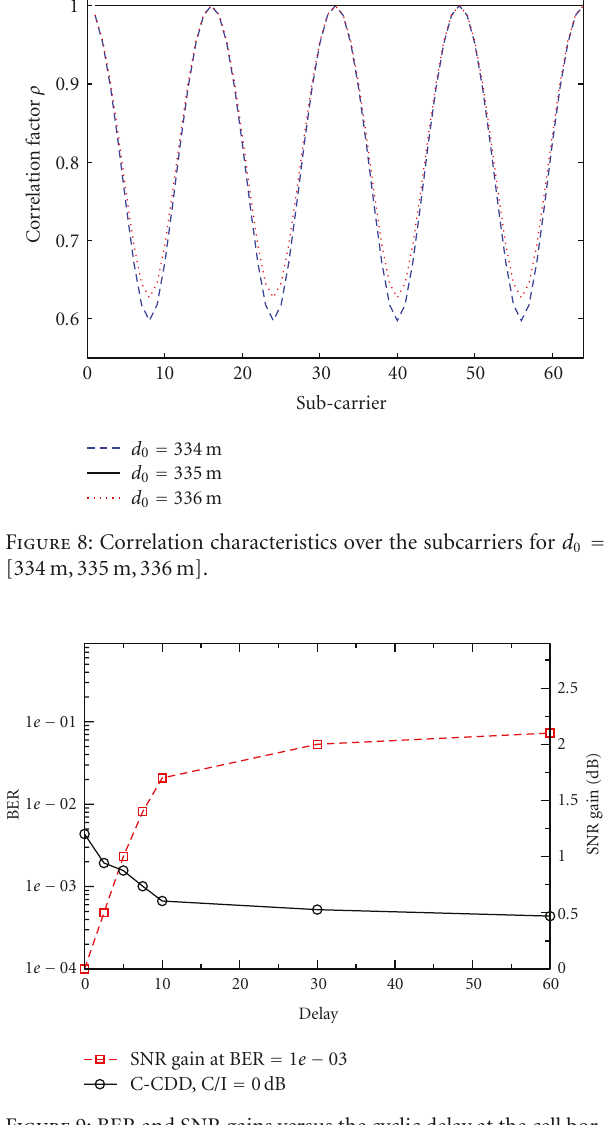
Figure 9: BER and SNR gains versus the cyclic delay at the cell bor- der (C/I =